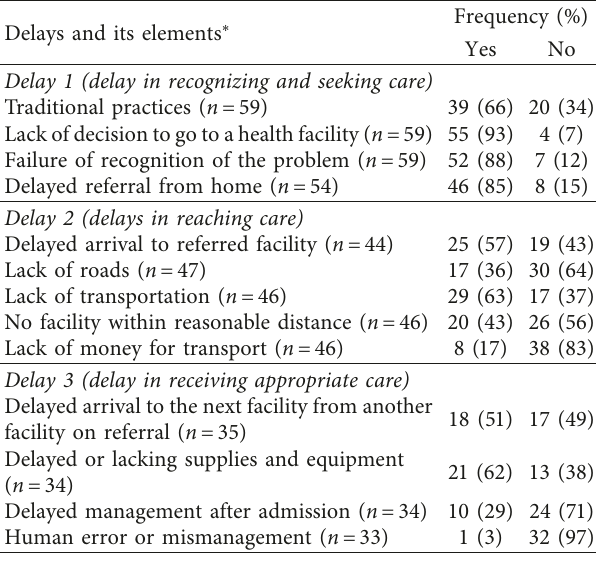
Table 5: Three delays for maternal death and its elements at pastoralist area of Borena zone, Oromia region, Ethiopia, 2017. Delays and its